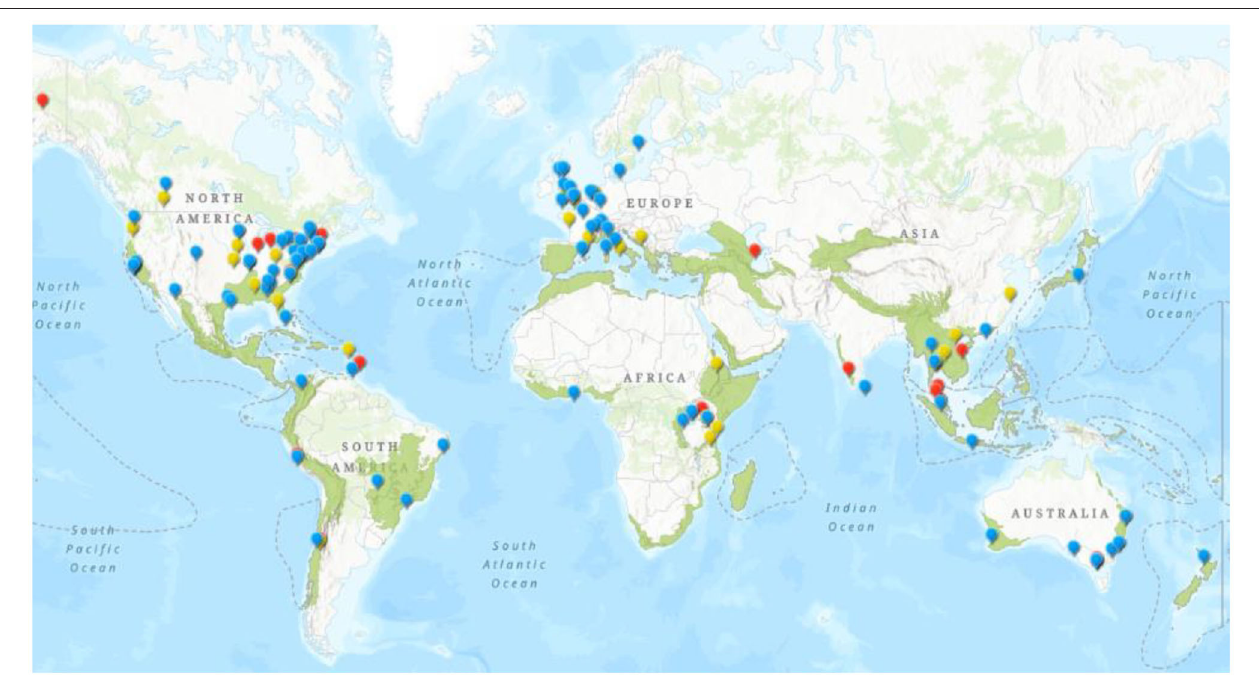
FIGURE 1 | Distribution of institutions teaching biodiversity and health interlinkages (blue icons, n = 88). Yellow icons represent those with indirect offerings ( n = 28); red icons, unclear offerings ( n = 18). Distribution is overlaid on biodiversity hotspots (